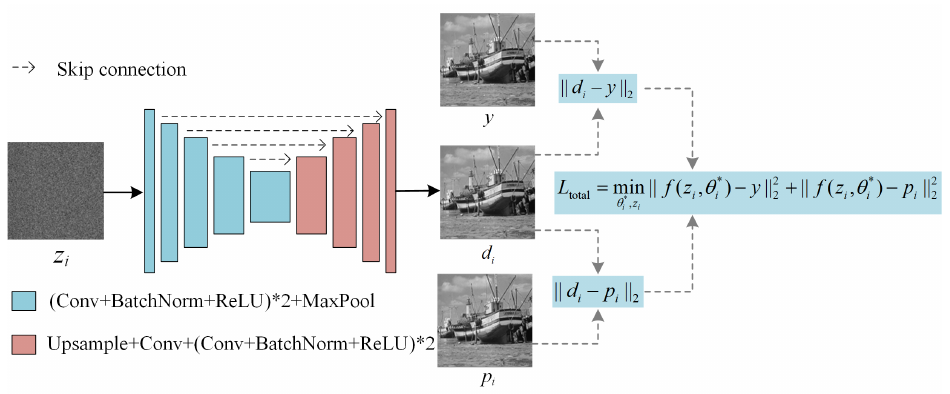
Figure 6. Framework of the intermediated denoising image